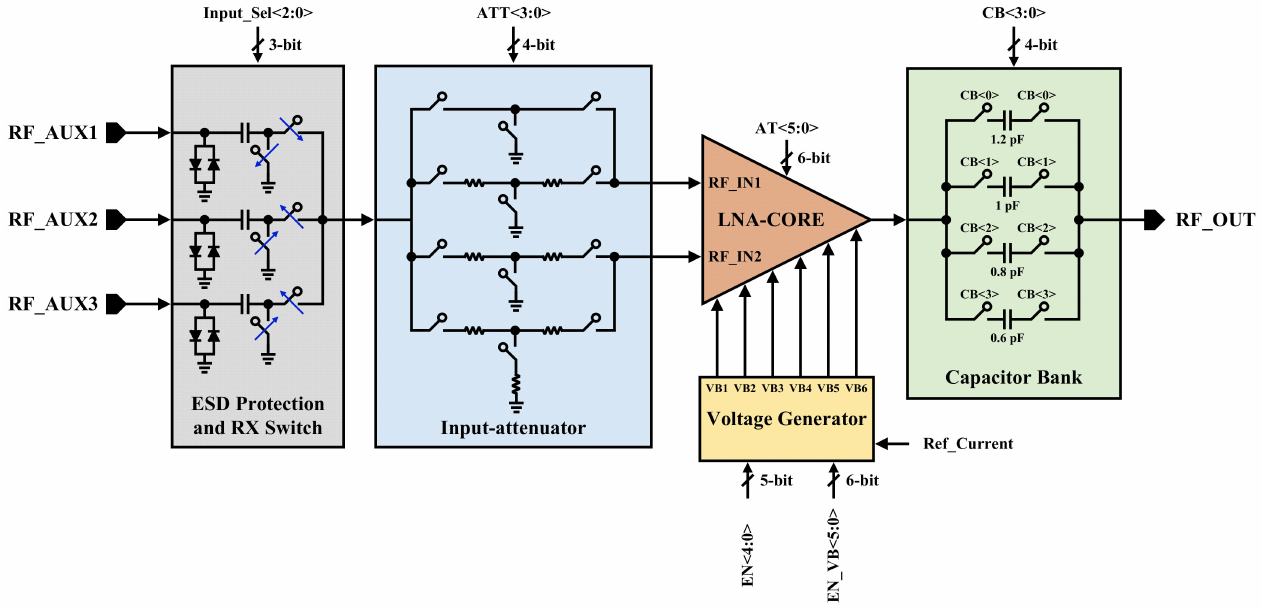
Figure 1. Top block diagram of proposed RF